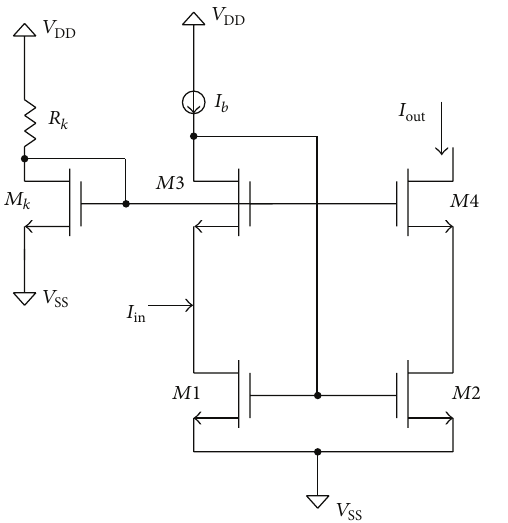
Figure 2: Conventional LVCCM, when input current is fed at the drain terminal of 𝑀1 .